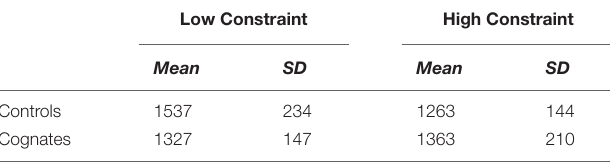
TABLE 2 | Means and standard deviations of first stroke latencies (in ms) as a function of sentence constraint and cognate